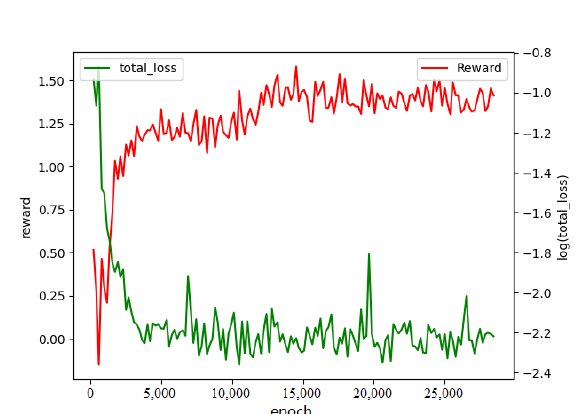
Figure 4. Iteration curve of loss value and reward value. The data are smoothed for five generations. In order to better observe the trend of data changes, the total _ loss data are logarithmically processed. Each evaluation of the agent goes through five interactions with the environment, and the final reward is stable at around 1.5, which is equivalent to an average reward value of 0.3 per interaction with the environment. That is, after the computation offloading plan, the current consumption is only 0.7 times of the local computation.